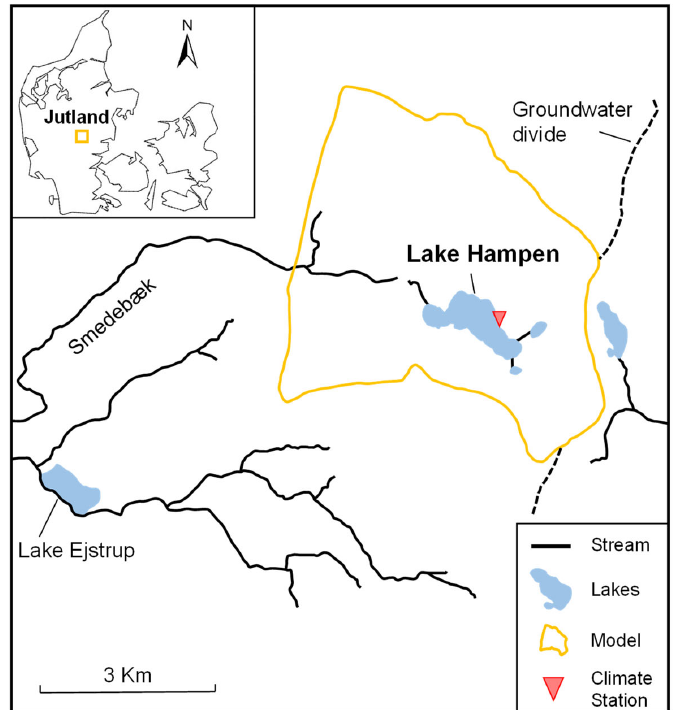
Figure 1. Location of Lake Hampen and the model domain.